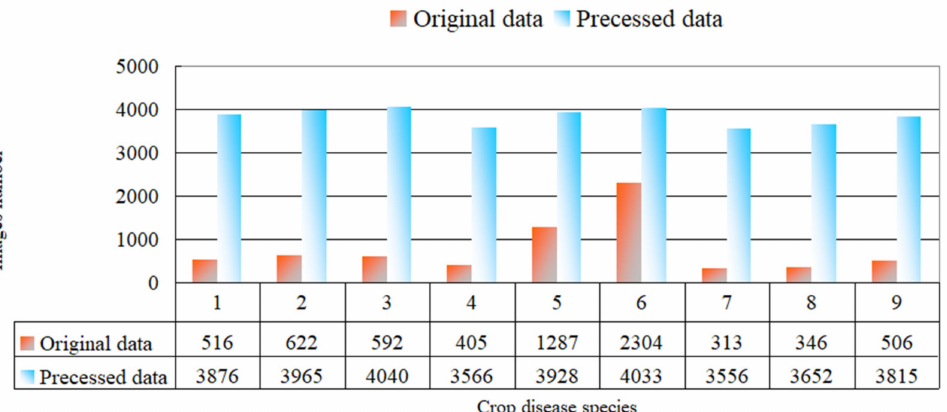
Figure 3. Number of images before and after augmentation, where 1~9 in the X axis represent Apple—healthy, rust, scab; Cassava—bacterial blight, brown streak, healthy, mosaic virus; Cotton boll—blight, healthy.